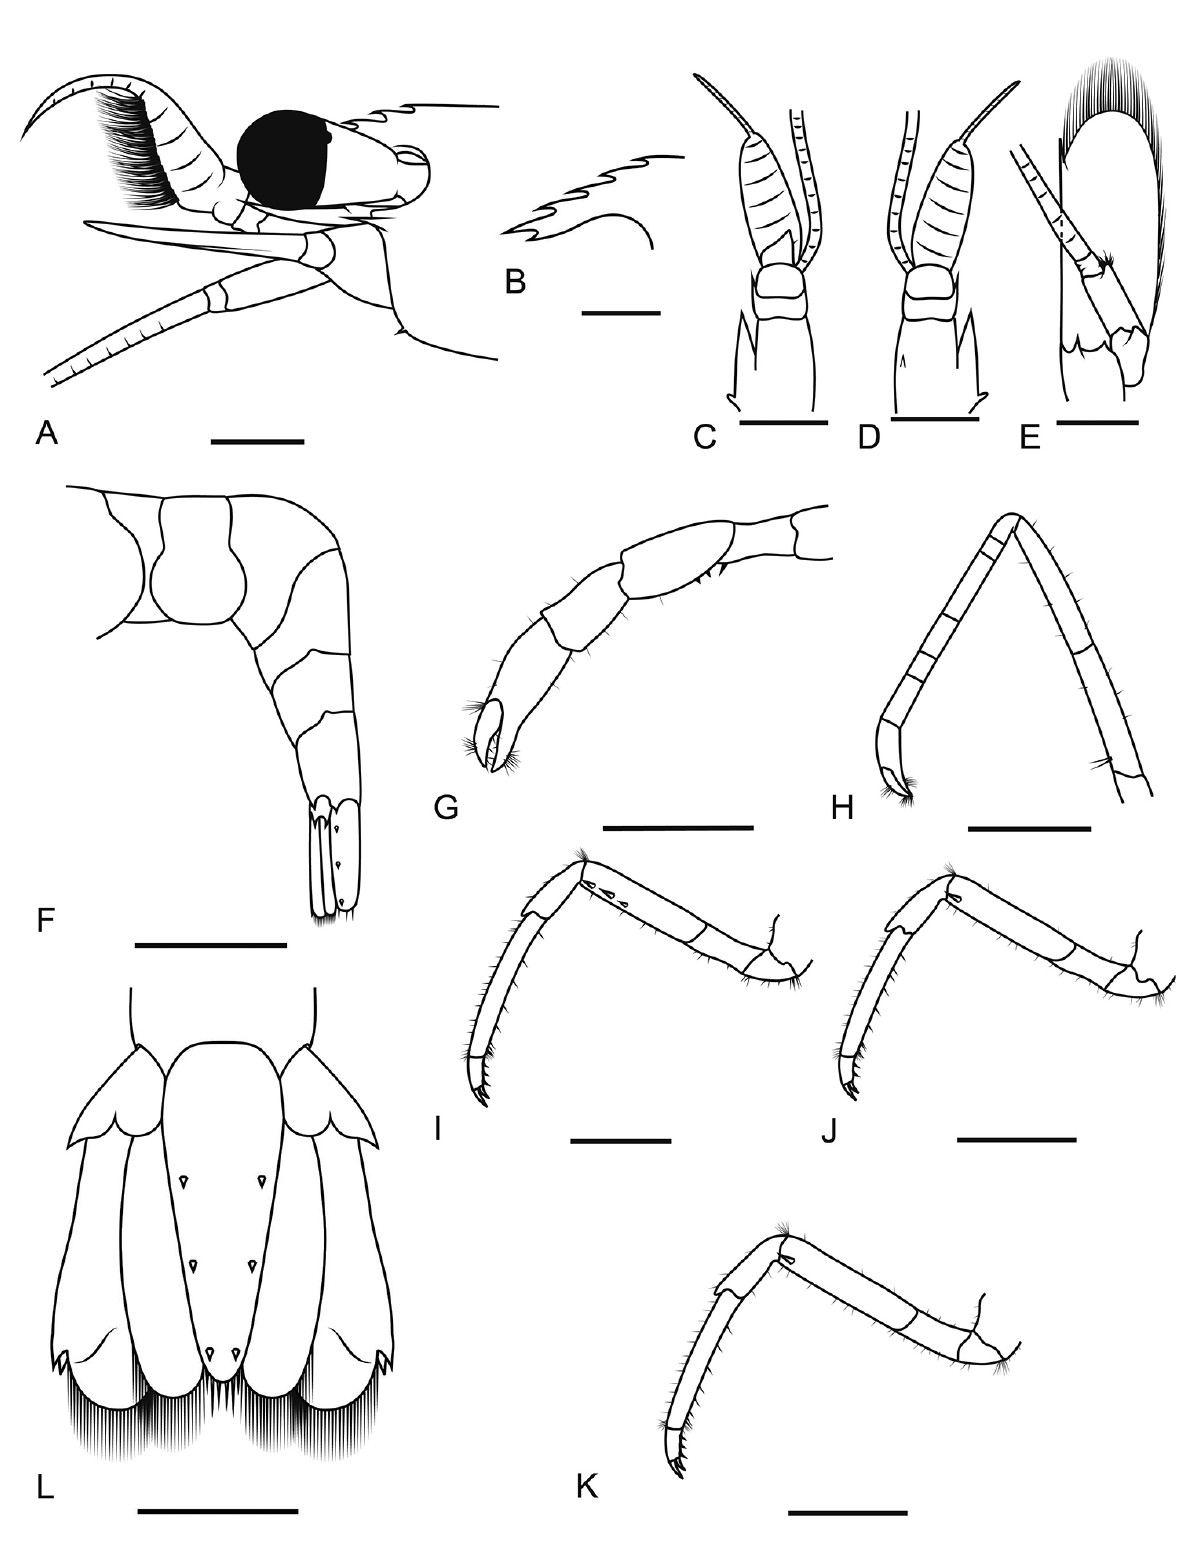
Figure 1. Thor paulae sp. nov. Panama, Bocas del Toro. Holotype, female (UF 60011). A , Carapace and cephalic appendages, left lateral view; B , rostrum, left lateral view; C , left antennule, dorsal view; D , left antennule, ventral view; E , left antenna, ventral view; F , pleon, left lateral view; G , left first pereopod, lateral view; H , left second pereopod, lateral view; I , left third pereopod, lateral view; J , left fourth pereopod, lateral view; K , left fifth pereopod, lateral view; L, telson and uropods, dorsal view. Scale bars: A, F–K: 0.83 mm; B: 1.0 mm; C–E: 0.625 mm; L: 0.25